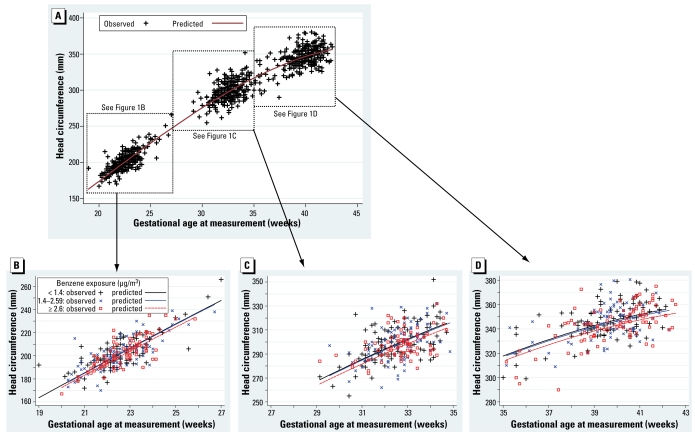
Head circumference as a function of gestational age at measurement and maternal benzene exposure. Head circumference was assessed between 19 gestational weeks and birth (A), between 19 and 27 gestational weeks (by ultrasonography) (B), between 27 and 35 gestational weeks (by ultrasonography) (C), and between 35 and 43 gestational weeks (after birth) (D). The predicted curves are adjusted for gestational age at examination (polynomial coding and interaction terms with all adjustment variables but education and center), sex, maternal passive smoking (questionnaire data), urinary cotinine level, prepregnancy weight, height, parity, maternal occupational exposure to paints or pesticides, month of conception, maternal education, and center.